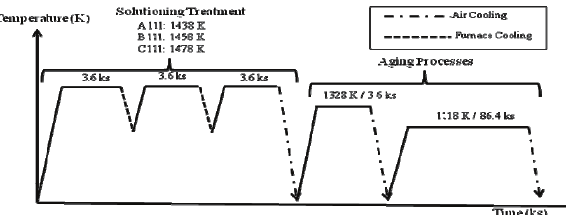
Figure 4. Simulated reheat treatment programs: A111, B111 and